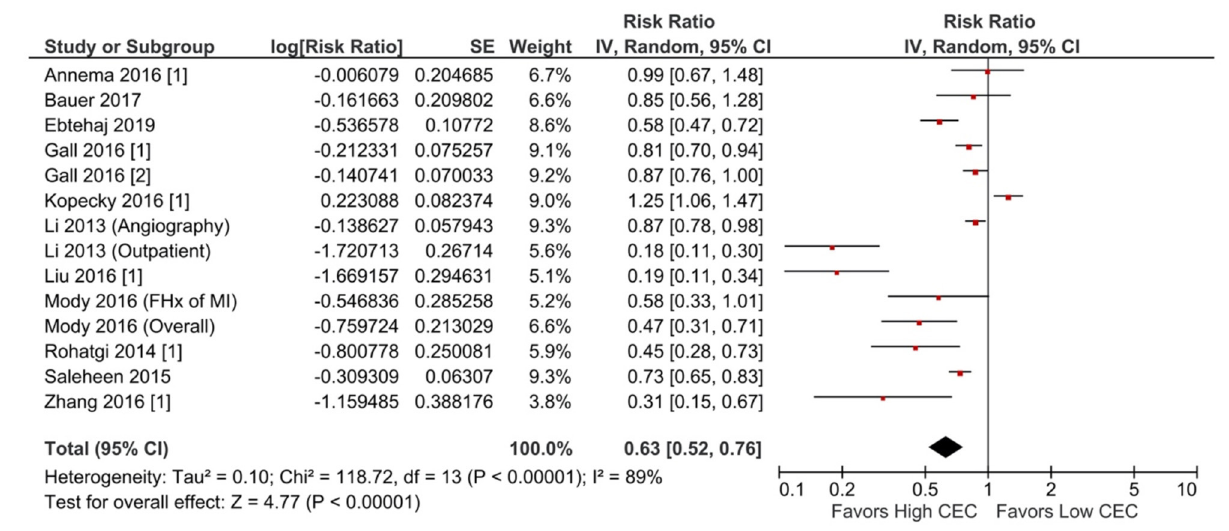
with cardiovascular risk factors (RR = 0.54; 95% CI, 0.38– 0.78; P = 0.001). Of note, the inverse relationship was